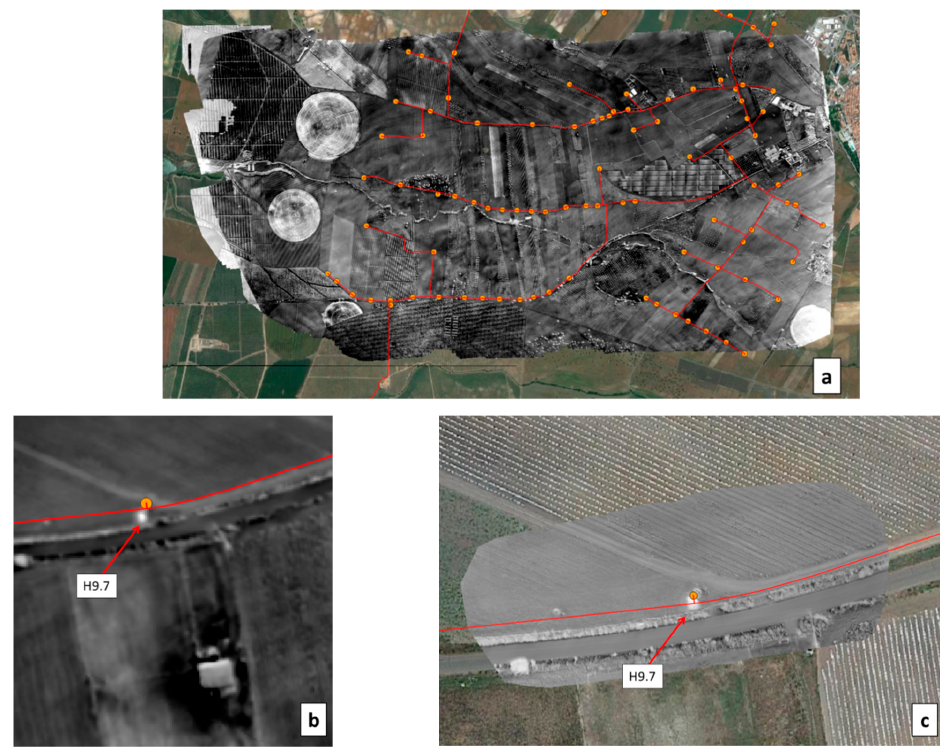
Figure 22. ( a ) WI image obtained with the MAV on 12 September 2019, over Ferreira district, Portugal, overlaid with the water distribution network (in red). ( b ) Detail of the WI image showing hydrant H9.7 and its artificial leak as obtained with the MAV. ( c ) WI image obtained with the UAV overlaid on a Google Earth image (in color).